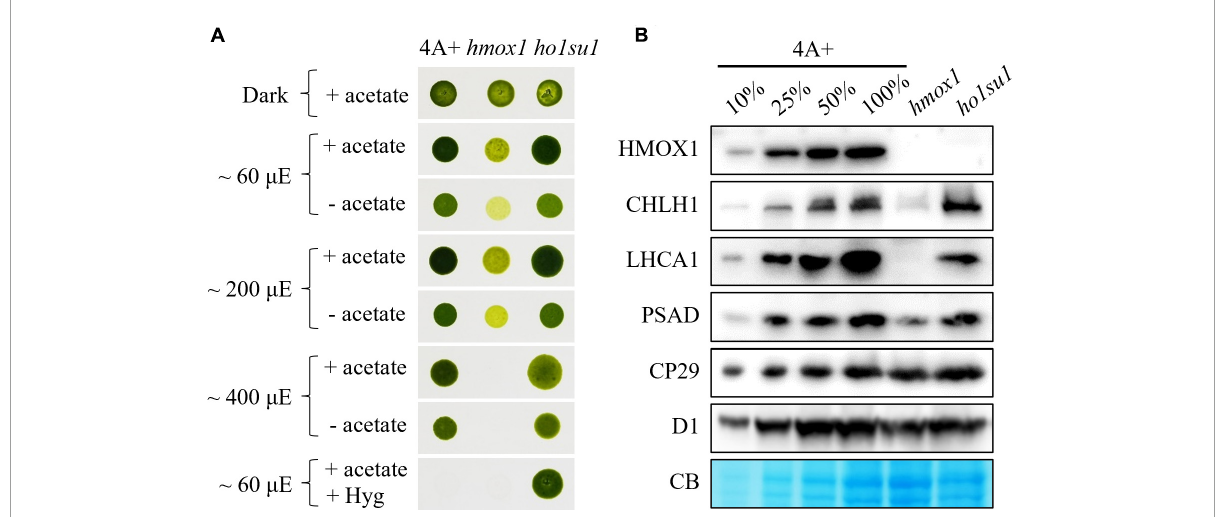
FIGURE1 Phenotypic analysis of the hmox1 suppressor ho1su1 . (A) Mixotrophic (+ acetate) and phototrophic (– acetate) growth of 4A+, hmox1, and ho1su1 in different light intensities. Hyg, hygromycin. (B) Immunoblotting analysis of HMOX1, the catalytic subunit of MgCh (CHLH1), representative proteins from PSI (LHCA1 and PSAD) and PSII (CP29 and D1) in 4A+, hmox1, and ho1su1 using specific antibodies. Coomassie blue staining (CB) was used to test for equal loading. Similar amounts of protein were loaded for each genotype. A dilution series (10, 25, and 50%) of total protein from wild-type 4A+ (100%) is provided to help evaluate protein